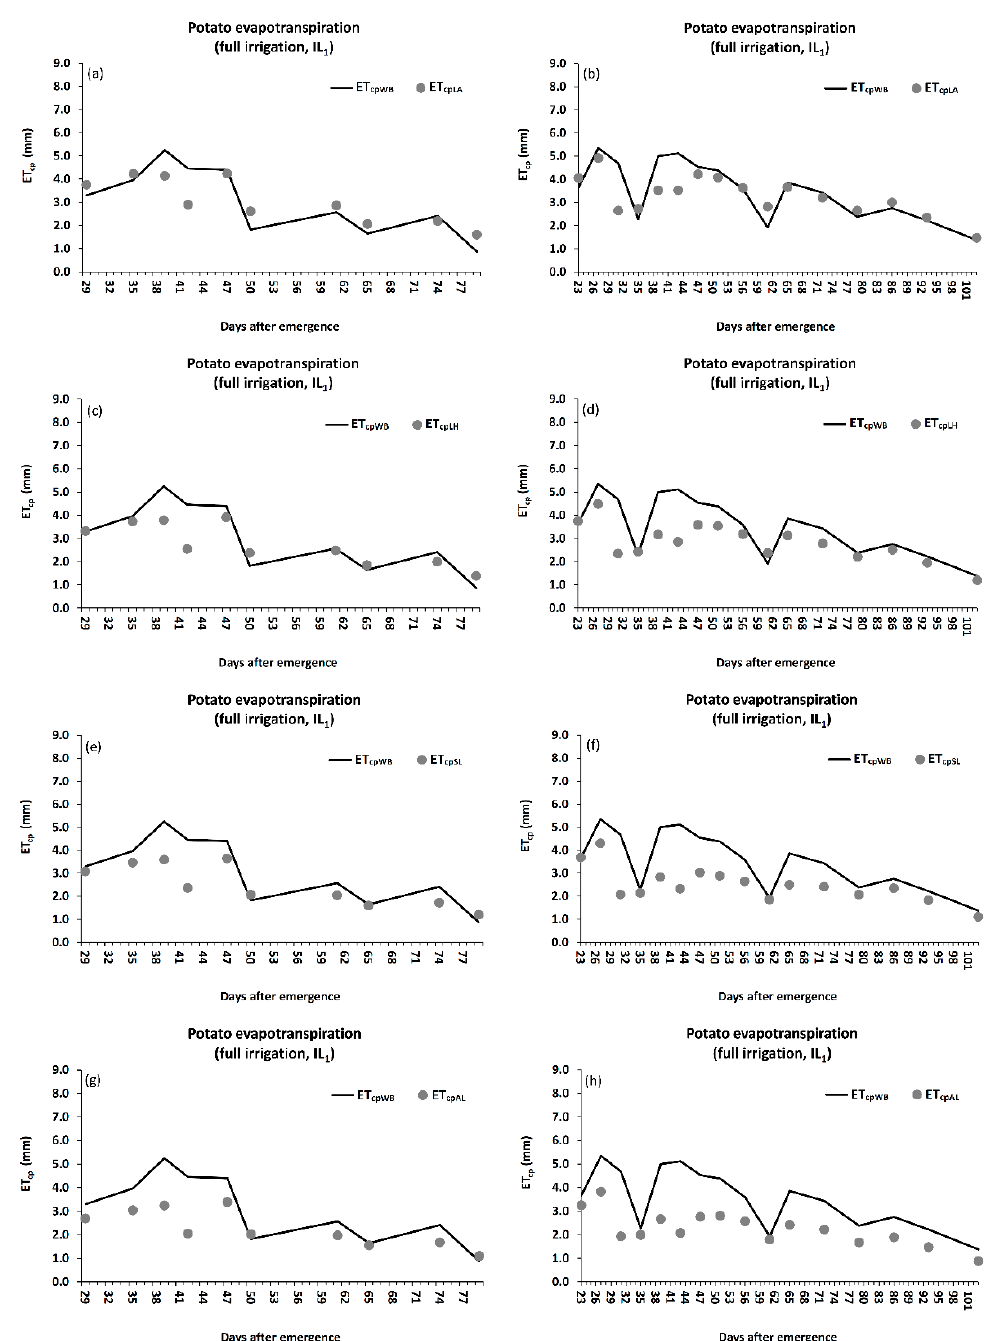
Figure 10. Comparison of daily average ET cp by soil water balance method and PM method with different canopy resistance approaches on a full irrigation condition (IL 1 ) for 2018/2019 ( a , c , e , g ) and 2019/2020 seasons ( b , d , f , h ).